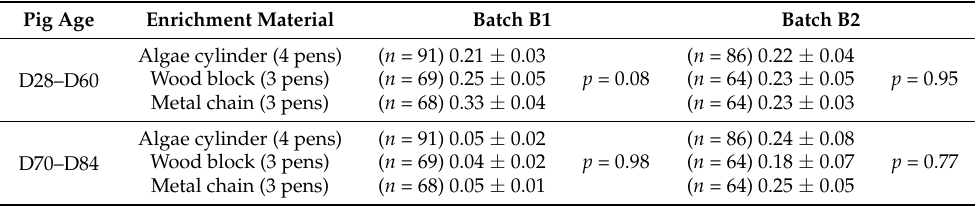
Table 2. Number of pigs (least square mean ± standard error, total number of observed pigs in brackets) manipulating the enrichment material per scan according to the material during the nursery period (Day 28 (D28) to D60 ( n = 11.823 scans)) and during the fattening period from D70 to D84 ( n = 1800 scans). The comparison of the material treatments was made with a mixed ANOVA model with the pen as a random effect ( p value). As a batch effect was detected, batches were analyzed separately.